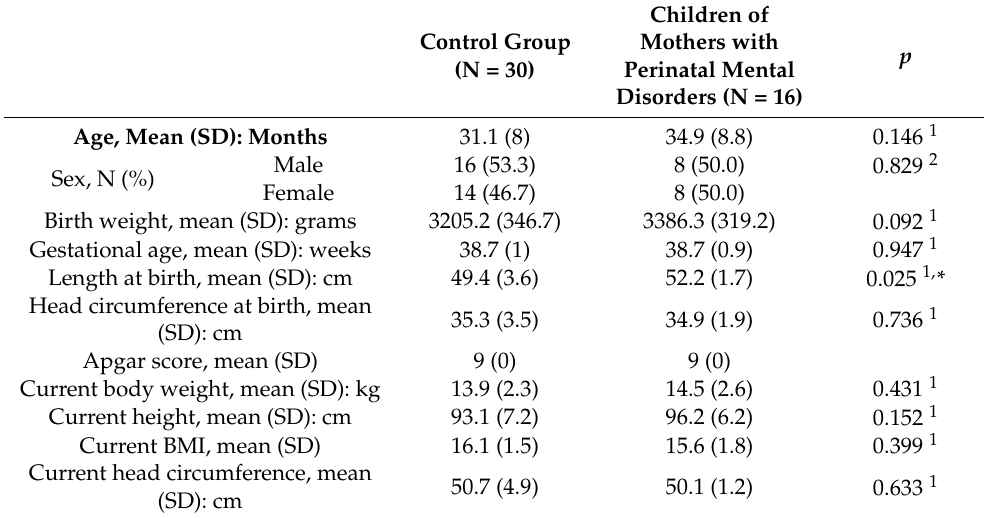
Table 2. Children’s characteristics (N =